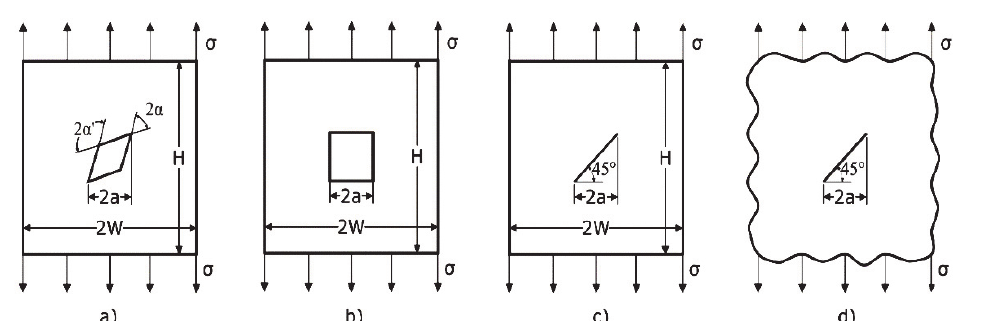
Figure 4: Case studied for the application of the method: diamond shape notch (a), square hole (b), central tilted crack in a finite plate (c) and central tilted crack in a plate of infinite extension